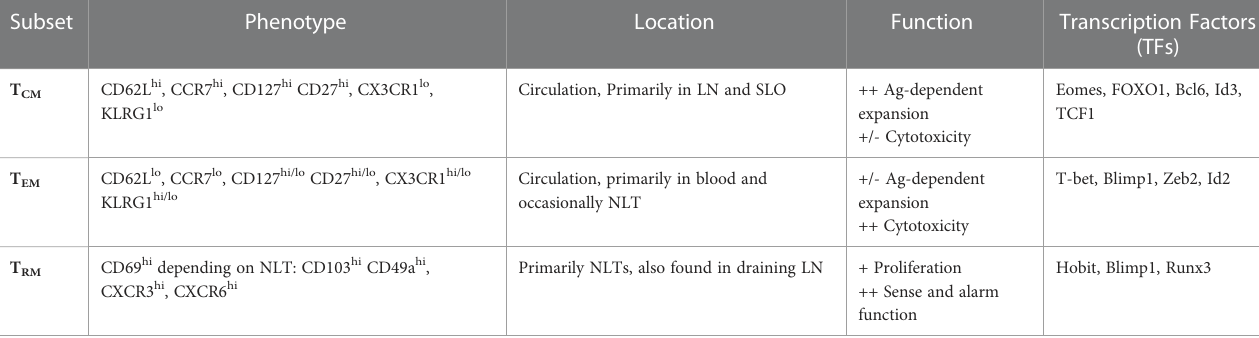
TABLE 1 Subsets of memory CD8 T cell pool and their